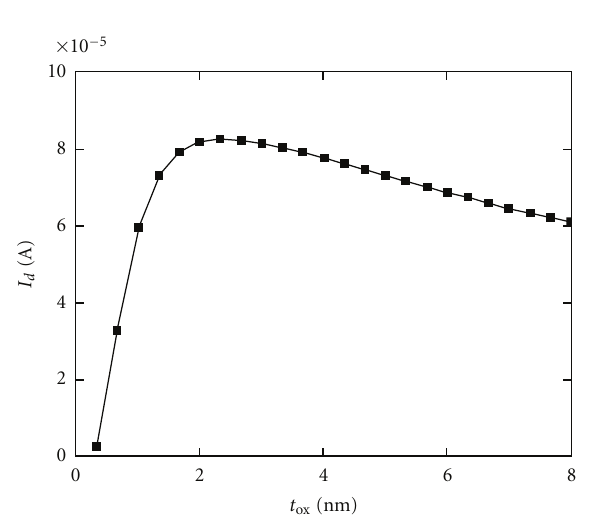
Figure 4: Drain current versus oxide thickness for V g = 1 . 5